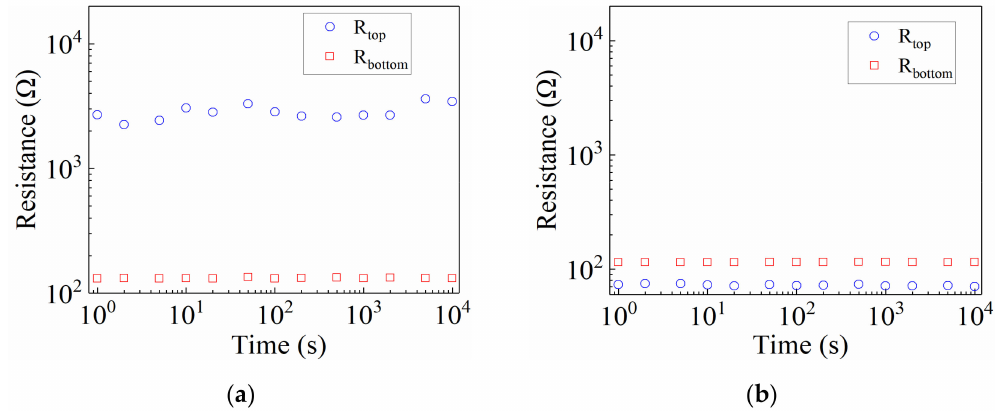
Figure 15. Resistance values of the RRAMs during unmasking-masking operation for 10 4 s. Initially, ‘0’ was written to the cell: ( a ) after unmasking; ( b ) after masking.